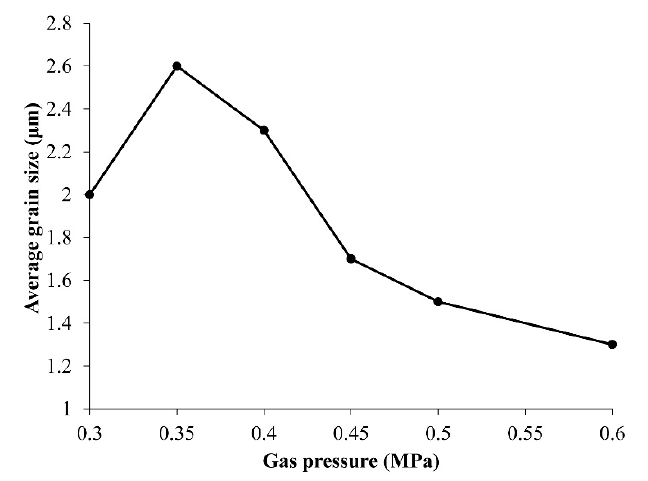
Figure 3. Relationship between average grain size of LNT with Ti 20 mol % and air pressure.